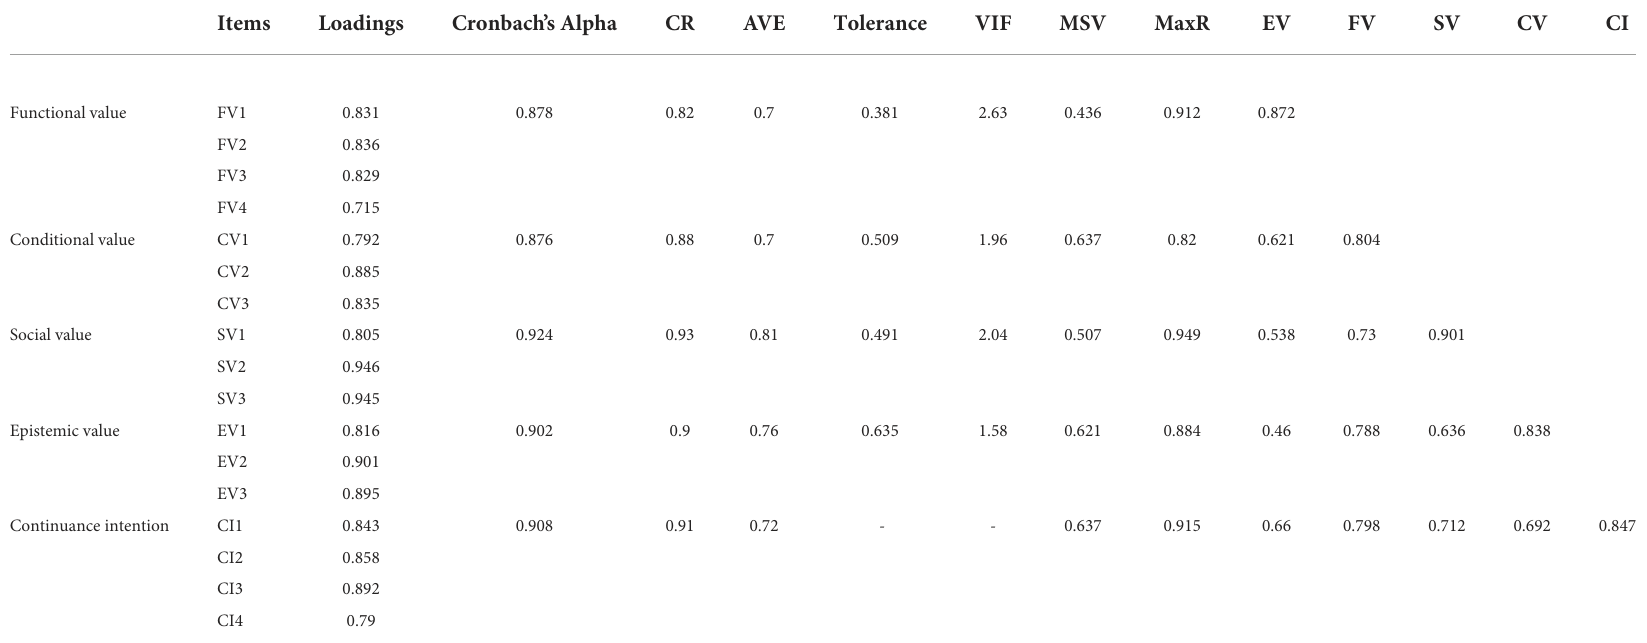
TABLE 2 Reliability and